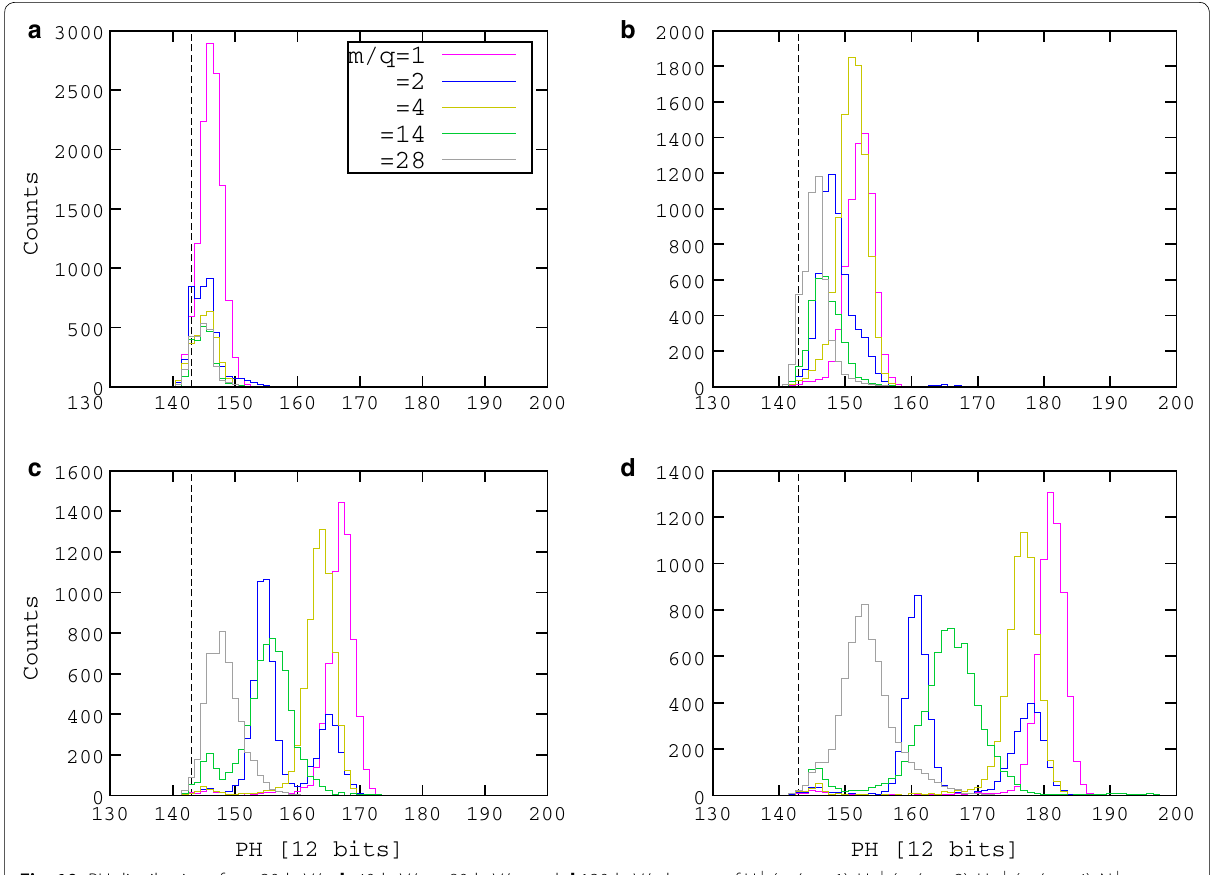
Fig. 10 PH distributions for a 20-keV/q, b 40-keV/q, c 80-keV/q, and d 120-keV/q beams of H + ( m/q ( m/q 14), and N 2 + ( m/q =